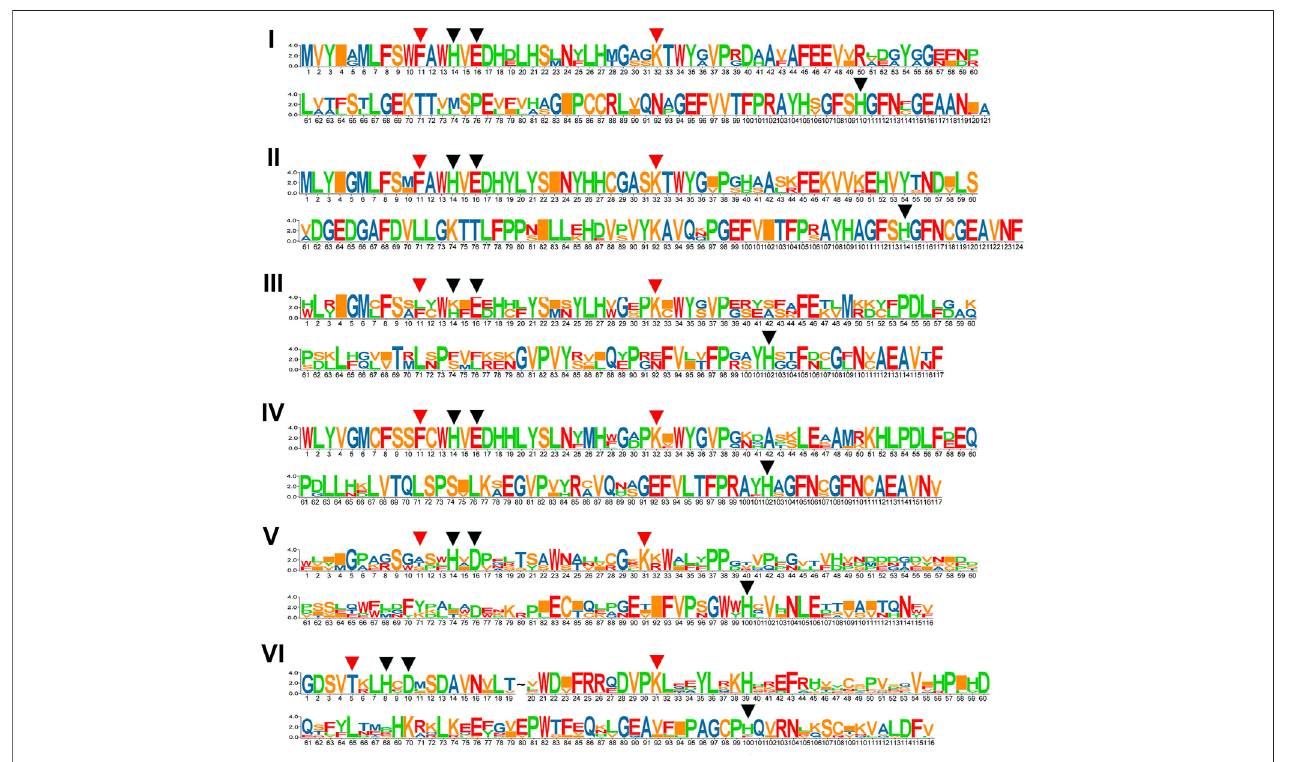
FIGURE2| TheconservationofJmjCdomainsinsix GhJMJ genesubfamilies.Fe(II)bindingsitesareshownwithredarrowheads,and α KGbindingsitesareshown with black arrowheads.